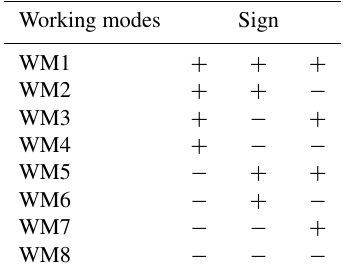
Table 1. Working mode signs. Working modes